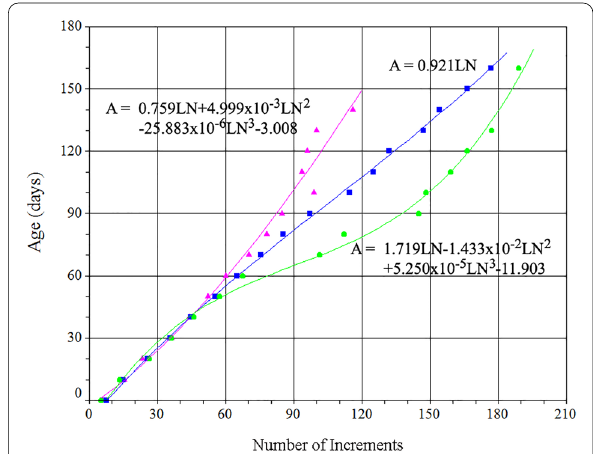
Fig. 3 Age (days) as estimated from number of increments, (circle— Sepioteuthis lessoniana , rectangle— Sepia pharaonis , triangle— Sepiella inermis )